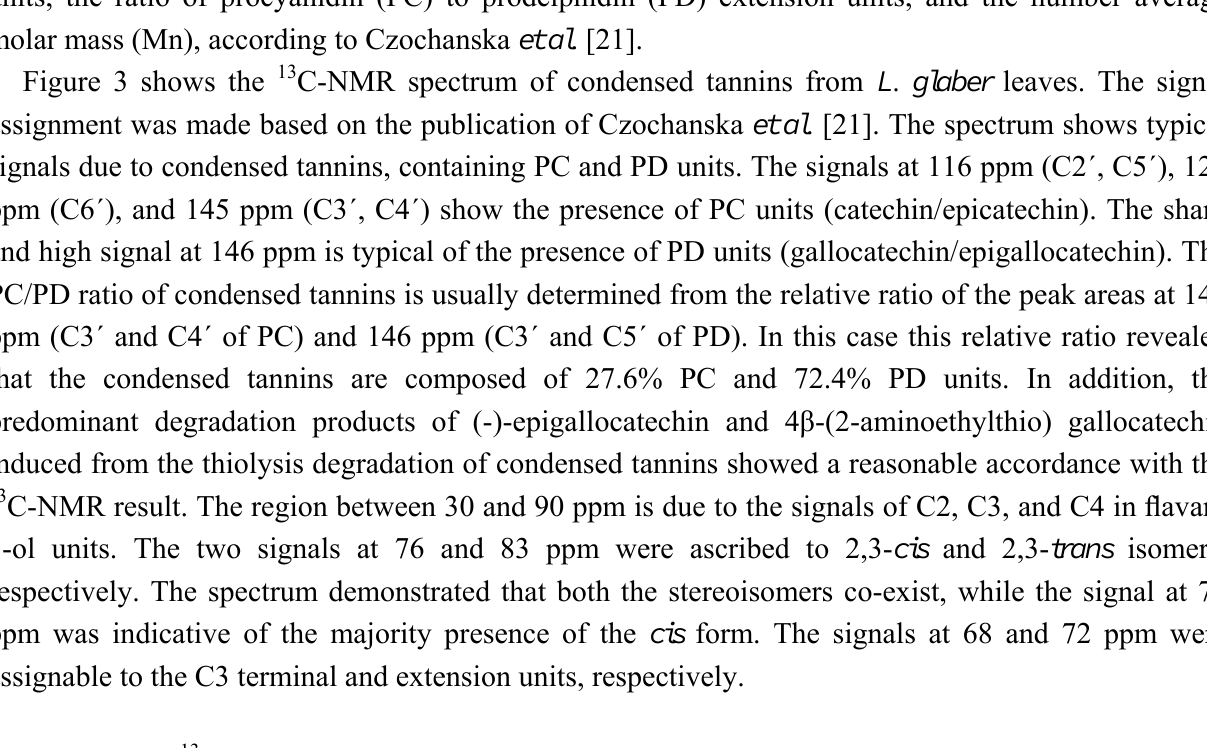
Figure 3. 13 C-NMR (150 MHz) spectrum of condensed tannins from L . glaber leaves in acetone- d /D O; t , terminal unit; m , middle unit; e , extension unit; PC, procyanidin; PD, 6 2